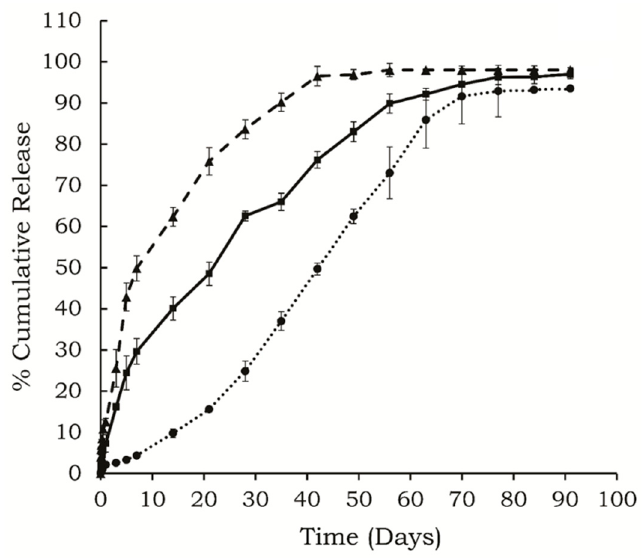
Figure 1. In vitro release profiles of ( ● ) risperidone, ( ▲ ) BSA, and ( ■ ) insulin released from 30% w / w copolymer containing delivery systems, ( n = 4, mean ± SD, drug loading: 0.3% w / v